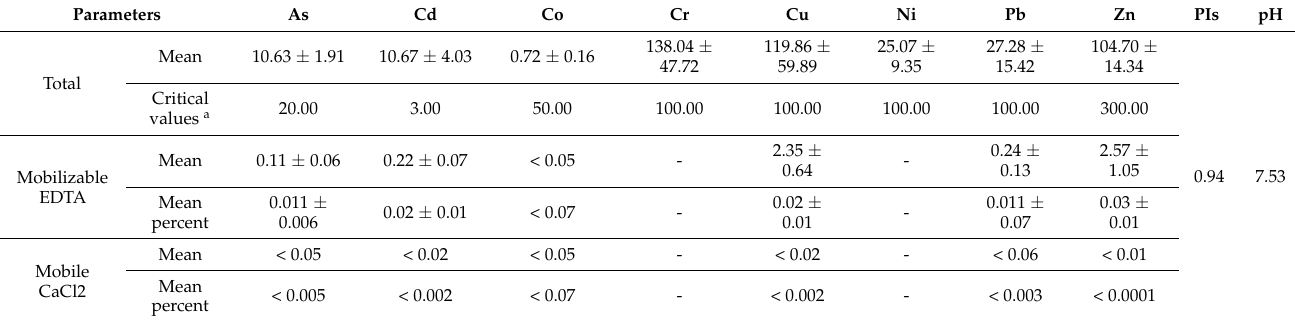
Table 1. Total concentrations, mobile and mobilizable fractions of metals and metalloids in the rhizospheric soils (mean ± SD, for three repetitions) in mg/kg, pH and the Soil Pollution Index (PIs) (unitless). The mobile and mobilizable data are expressed as percentages of the different fractions relative to the total in the phosphate